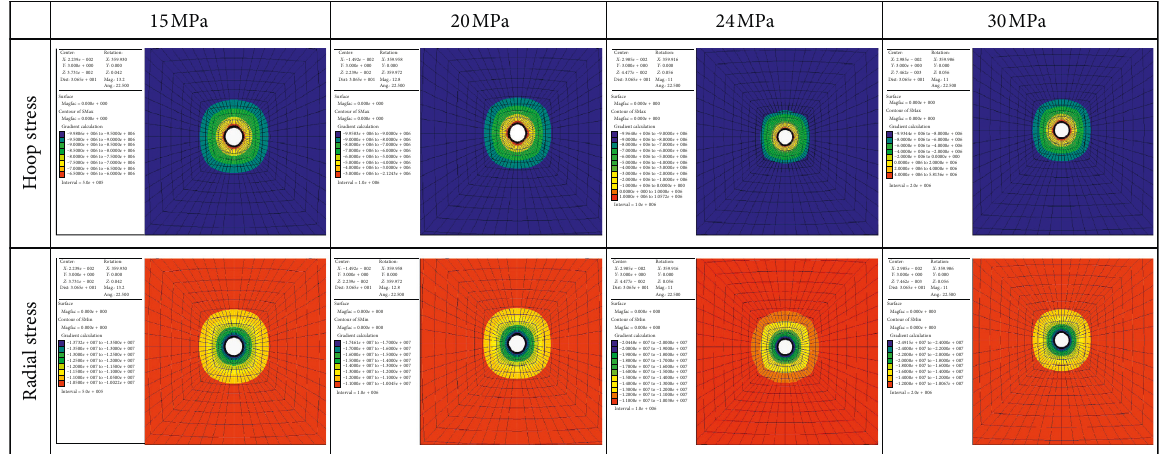
Figure 5: Stress contour under fracturing loads of 15 ∼ 30